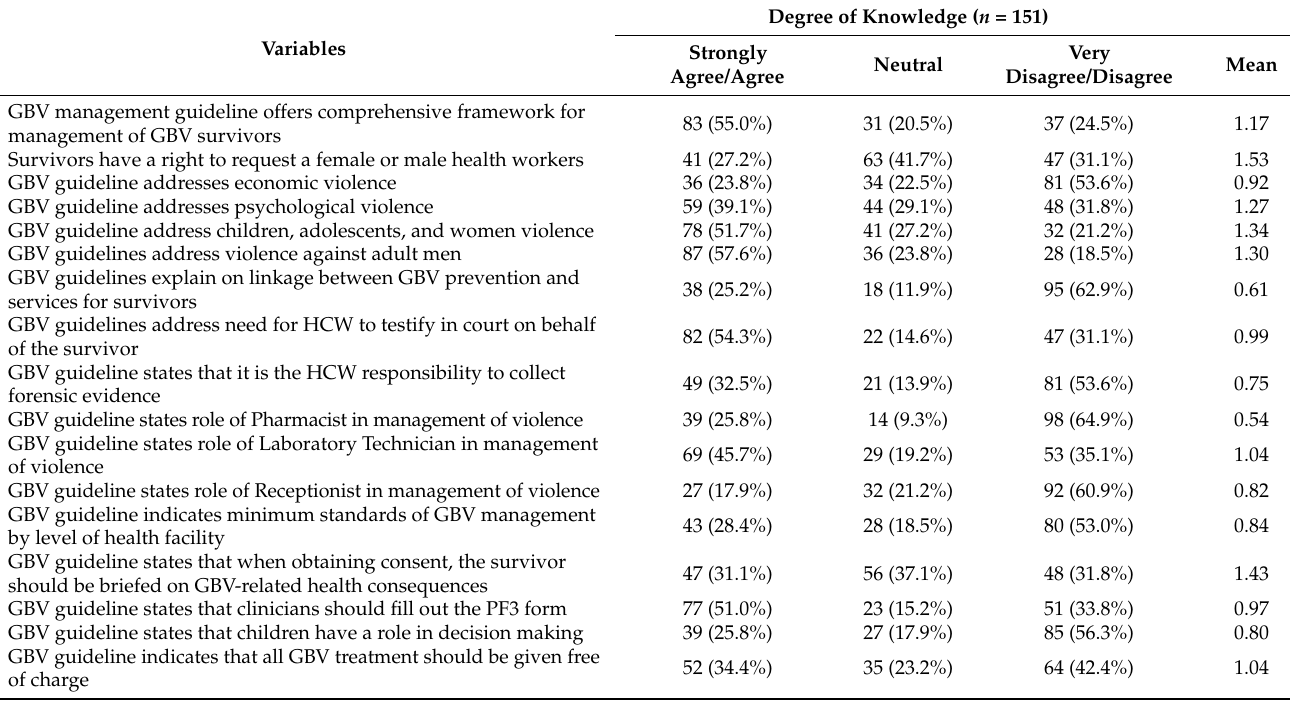
Table 3. Knowledge of gender-based violence (GBV) management guidelines among